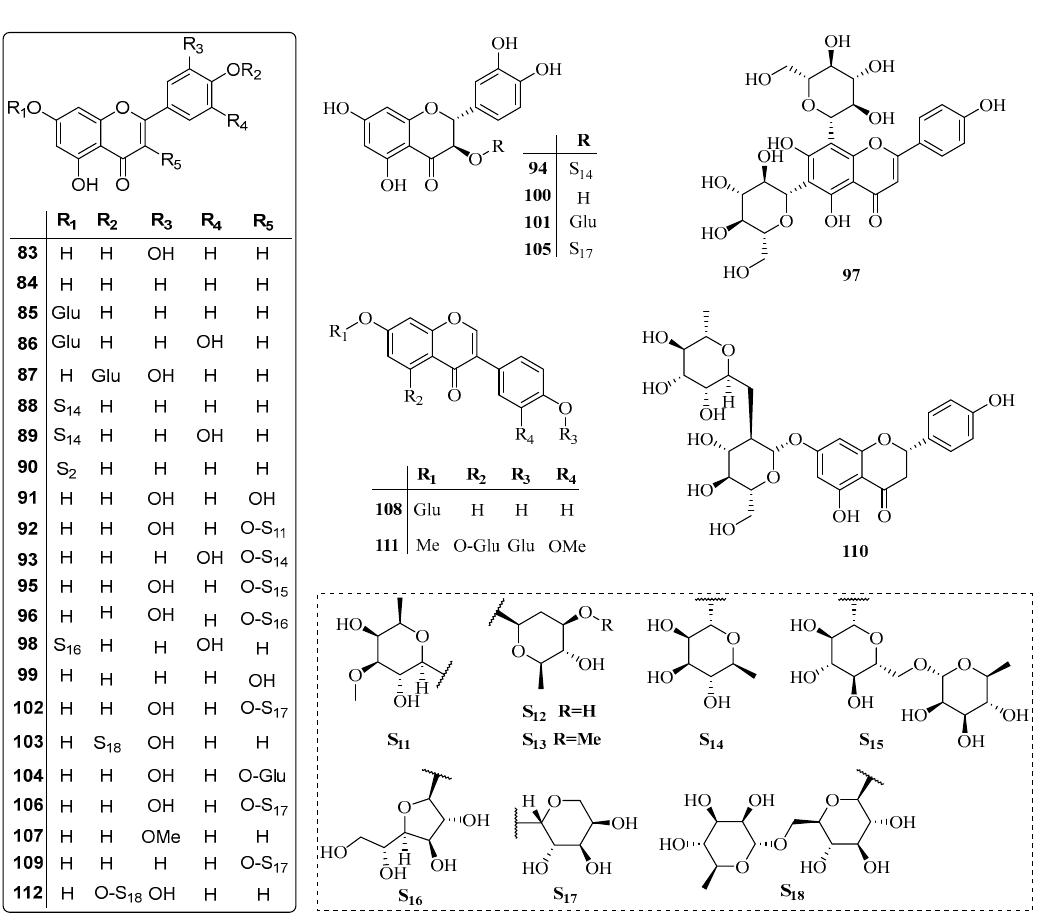
Figure 4. Flavonoids from the Trachelospermum plants.